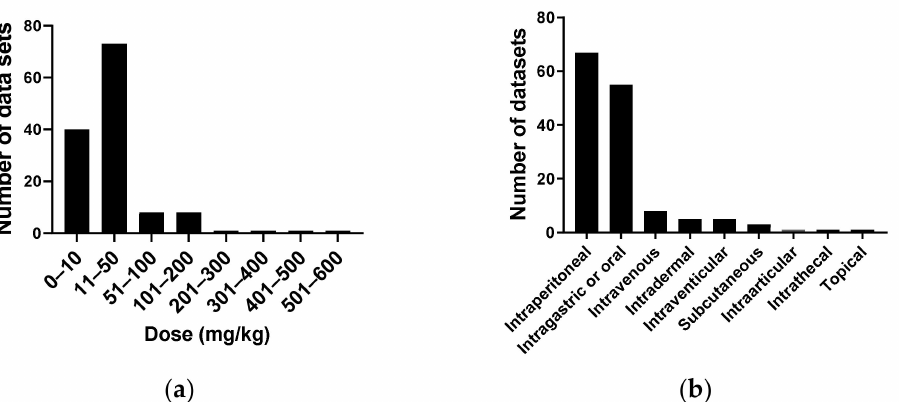
Figure 9. Dose of cordycepin administered to animal models in mg/kg. ( a ) A total of 133 studies were classified according to the range of cordycepin dose administered to the animal model; ( b ) The route of administration of cordycepin in 146 studies.In this systematic review, 167 articles studying the effects of purified cordycepin in a variety of animal models were found (see Table 3). We noted the details of the experimental set-up (species, model of human disease, dose in mg/kg basis and route of administration). The disease models were classified and counted (Figure 10). The majority of studies were of animal models of cancer, closely followed by cardiovascular diseases, infections and central nervous system